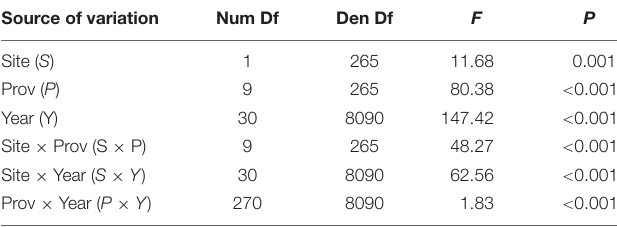
TABLE 4 | Results of the GEE analysis to test for differences in ring width due to sites, provenances, years and interactions analyzed with F test for type 3